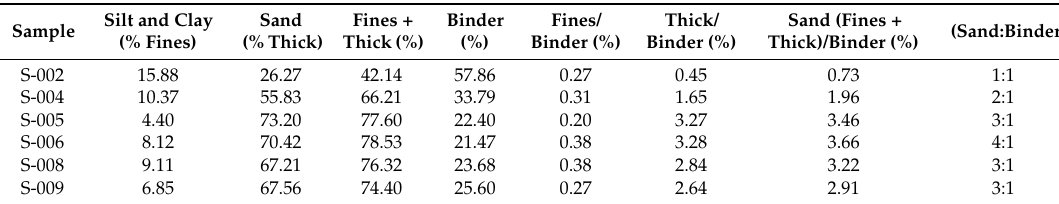
Table 4 . Mortar’s reconstitution. Table 4. Mortar’s reconstitution.